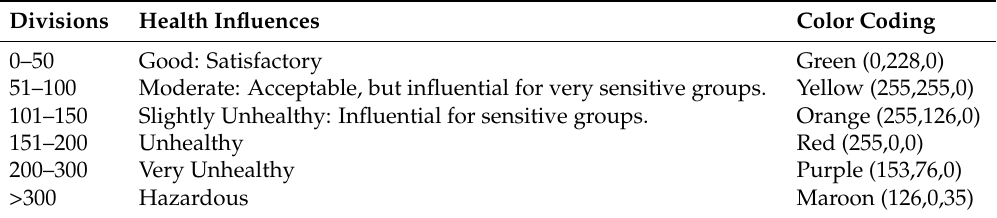
Table 2. Air Quality Index level divisions, descriptors and colors.